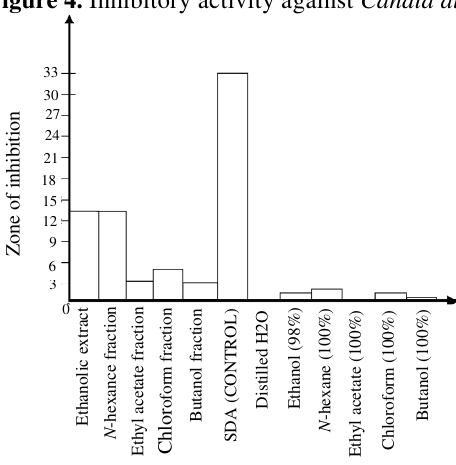
Figure 5. Inhibitory activity against Trichophyton violaceum